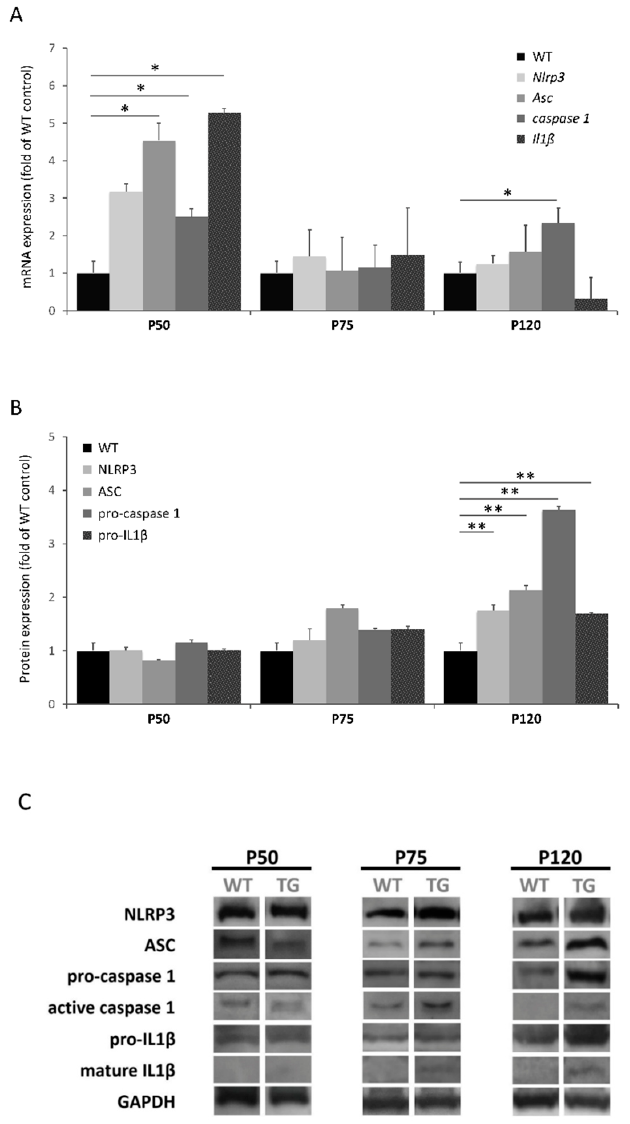
Figure 1. Expression levels of NLRP3 inflammasome in skeletal muscle of SOD1G93A mice during disease progression (P50: asymptomatic stage; P75: early symptomatic stage; P120: terminal stage). ( A ) Transcriptional levels of NLRP3 inflammasome components determined by real-time PCR in the quadriceps tissue. Dunnet’s post hoc test correction between groups also yielded statistically significant differences among groups at the asymptomatic stage ( Asc , p = 0.037; caspase 1 , p = 0.046; Il1 β , p = 0.041). ( B ) Protein expression levels of NLRP3 components in quadriceps muscle determined by Western blotting. Dunnet’s post hoc test correction between groups also yielded statistically significant differences among groups at the terminal stage (NLRP3, p = 0.025; ASC, p = 0.007; pro-caspase 1, p = 0.003; pro-IL1 β , p < 0.000). ( C ) Protein bands of each NLRP3 inflammasome component. Active caspase 1 and mature IL1 β were only detected in SOD1G93A mice. The total number of animals used was 24 (8 mice for each stage: WT n = 4 and SOD1G93A n = 4). * p < 0.05, ** p < 0.01; significant differences in comparison to WT mice.